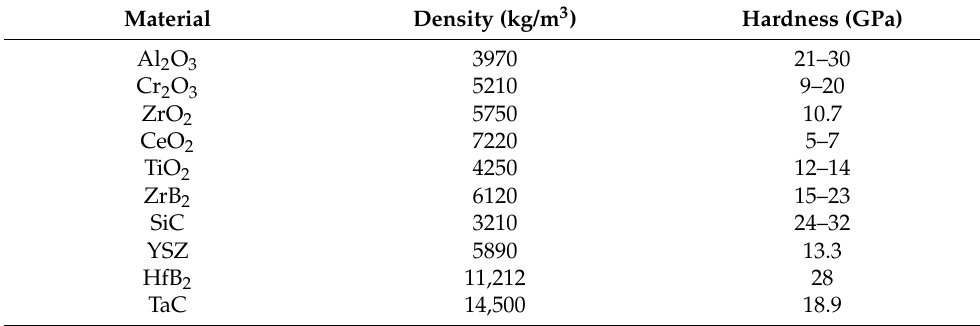
Table 1. Density and hardness values of various reinforcing materials [41–46].